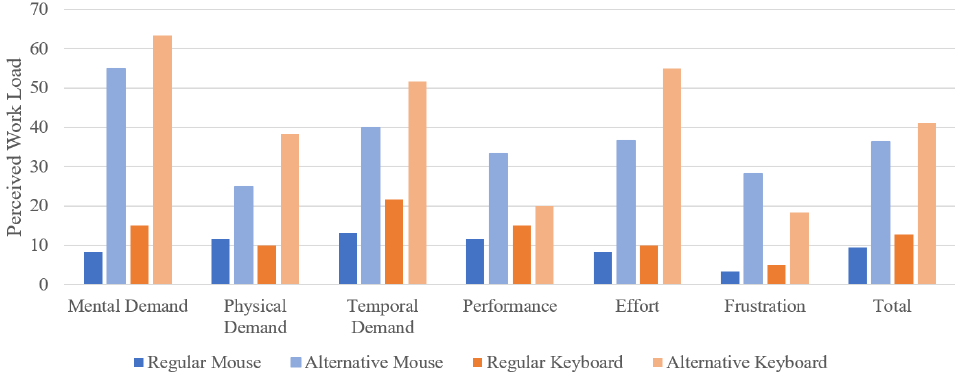
Figure 15. Perceived workload for six subscales of the Raw-TLX questionnaire, for the alternative and regular input